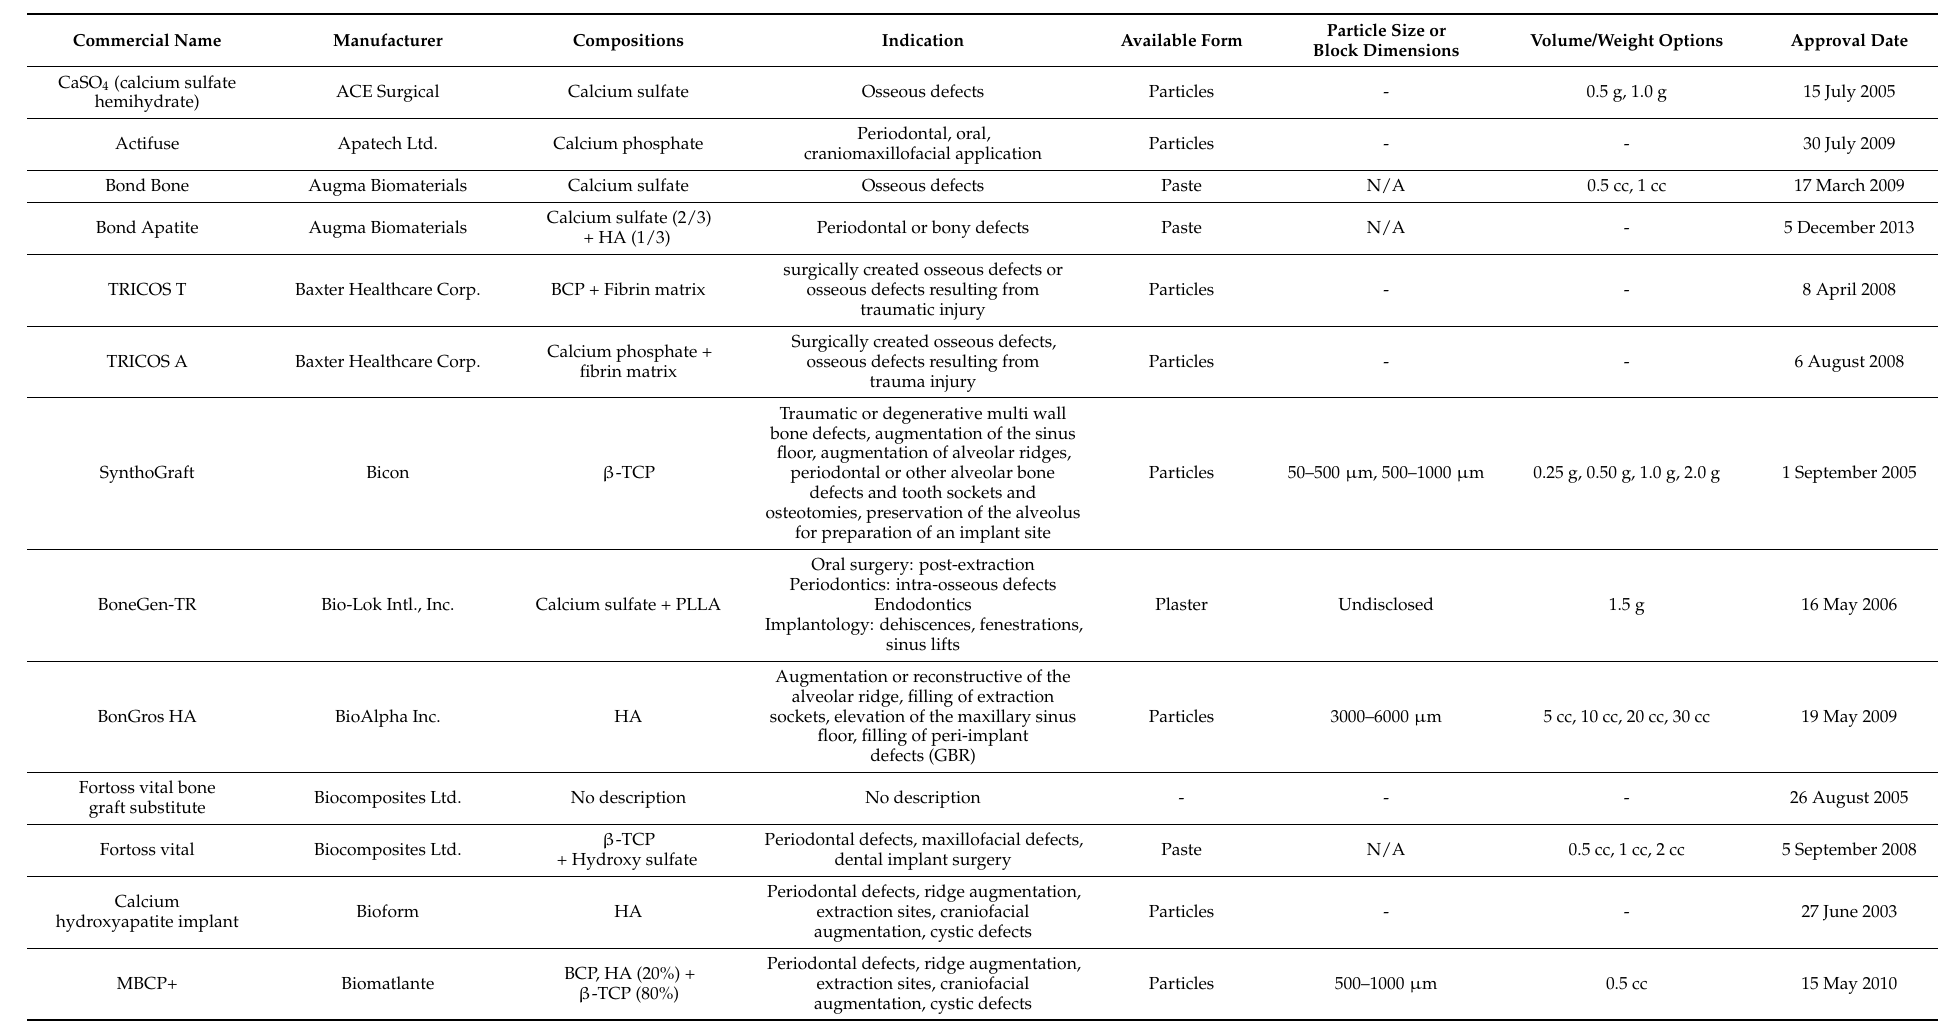
Table 1. Dental alloplastic bone substitute products for periodontal and oral implant applications that have been approved (510(k)) by the Food and Drug Administration